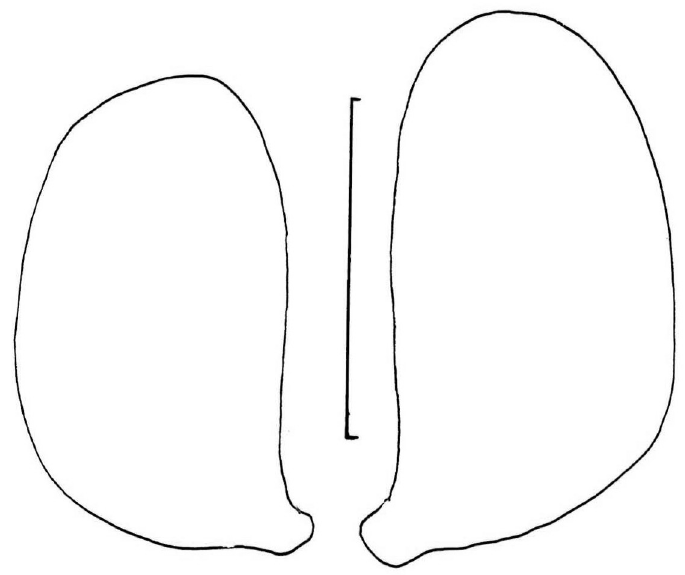
Figure 31. Mycetinis curraniae . Basidiospores. Standard bar = 5 µm. ZT 949